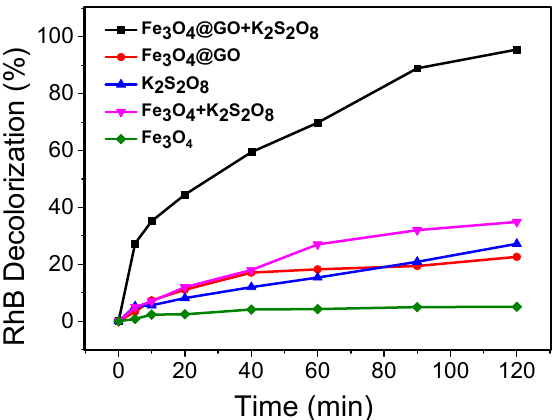
Figure 2. Decolorization of Rhodamine B (RhB) under different conditions with time. Reaction conditions: 200 mg catalyst + 20 ppm RhB + 1.5 mM K2S2O8 + 4.34 pH + agitate at room temperature (20 °C).